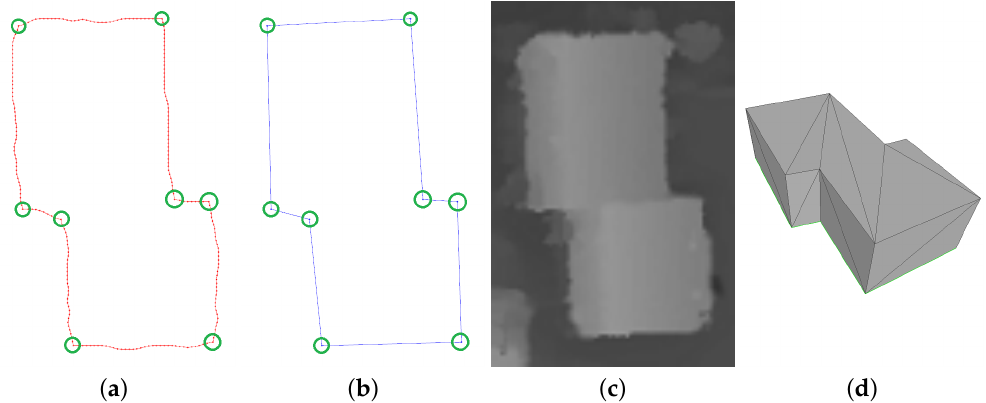
Figure 6. Generating LOD models from the deformed contour in Figure 5. ( a ) is the deformed contour with corner vertexes in green circles. ( b ) is the LOD0 model of simplified polygon reducing the vertexes from 499 to 8. ( d ) is the LOD1 model by extruding the contour to the averaged height in ( c